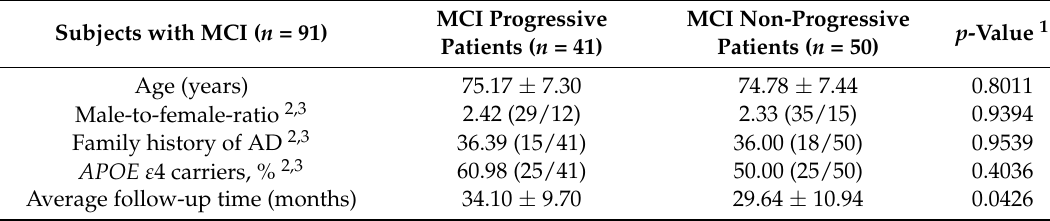
Table 2. Baseline Characteristics of mild cognitive impairment (MCI) Study